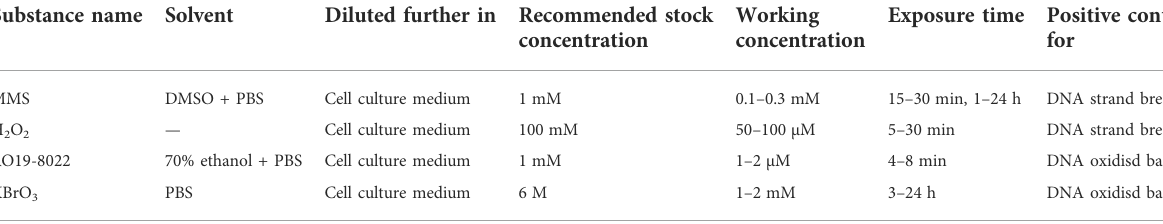
TABLE 1 Examples of positive control chemicals to be used for the comet